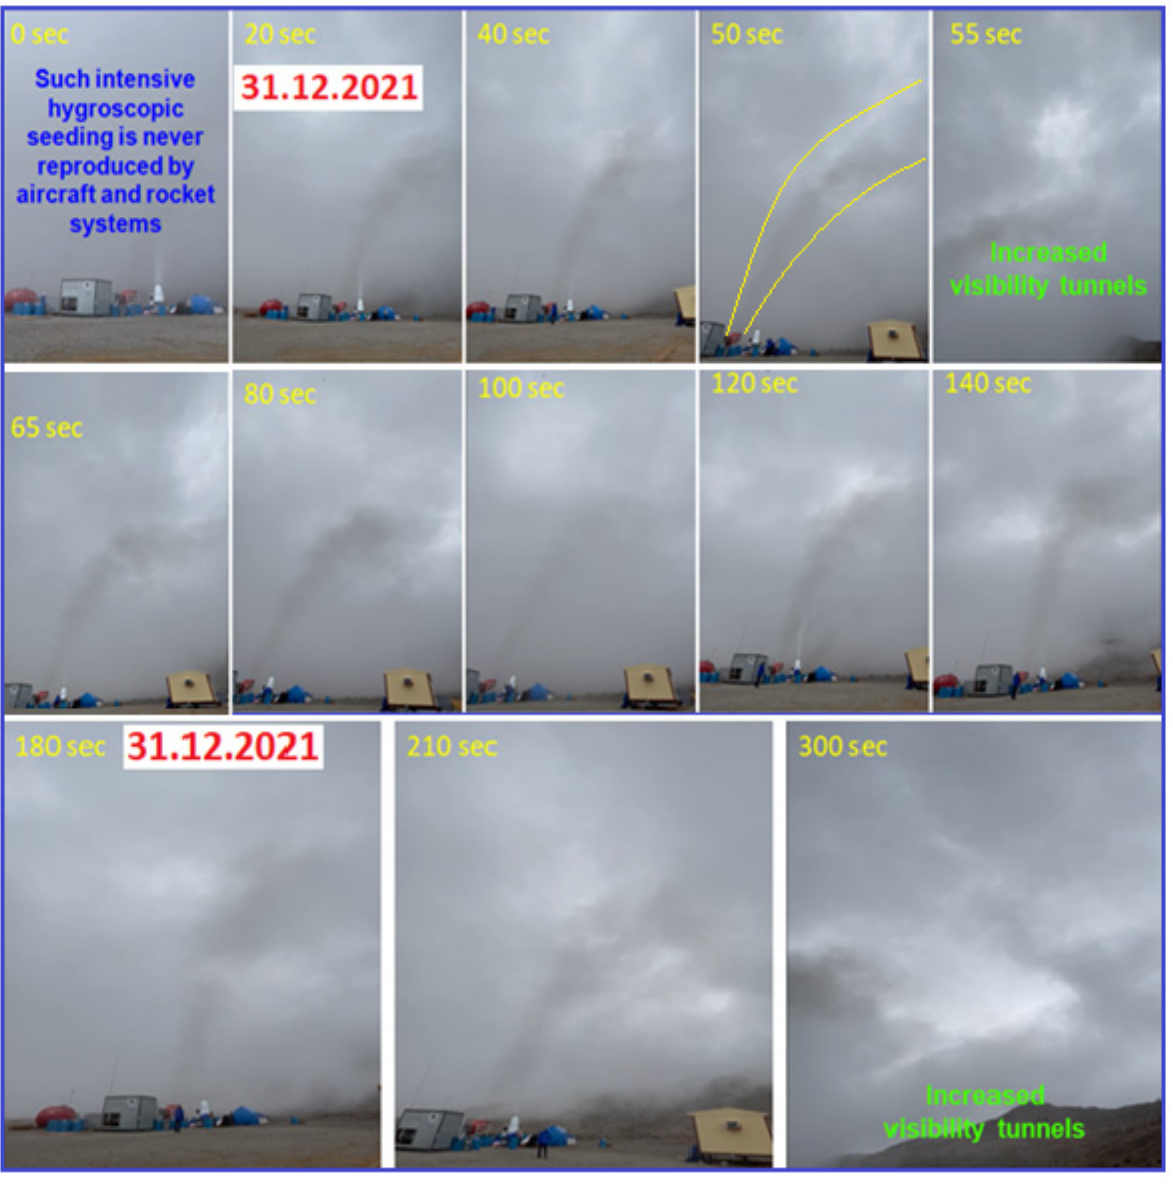
Figure 12. Impact on Cu cloud approaching experimental site from East. Rain and thunderstorm over site from 11:55 to 12:05 local time with a break. Rain intensity I = 99 mm/h, peak I max = 125 mm/h, which caused the water flow in the valley next to the experimental site.